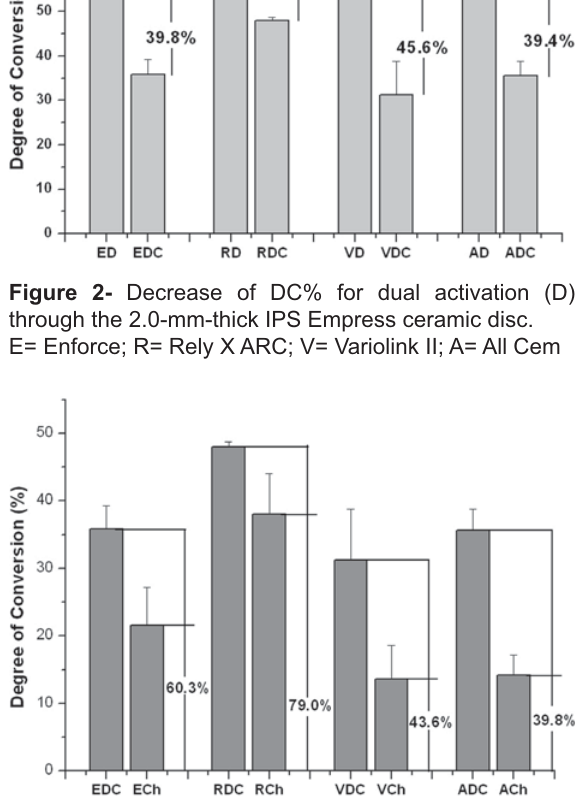
Figure 3- Comparison of the DC% between chemical activation (Ch) and dual activation performed through 2.0 mm IPS Empress 2 ceramic disc material. E= Enforce; R= Rely X ARC; V= Variolink II; A= All Cem aliphatic C=C bond (1638 cm -1 ) to the aromatic C=C (1608 cm -1 ), used as an internal standard, obtained from the polymerized and unpolymerized specimens